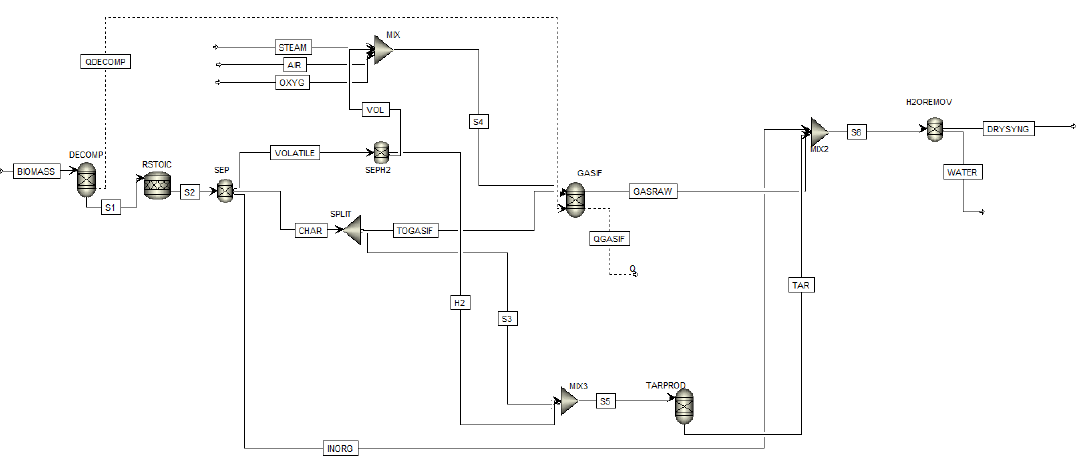
Figure 3. Aspen Plus simulation flowsheet of the auto-thermal BFB gasification reactor (the dashed streams are heat streams; the continuous streams are material streams). The reactions considered in the gasification process are reported in Table 4.